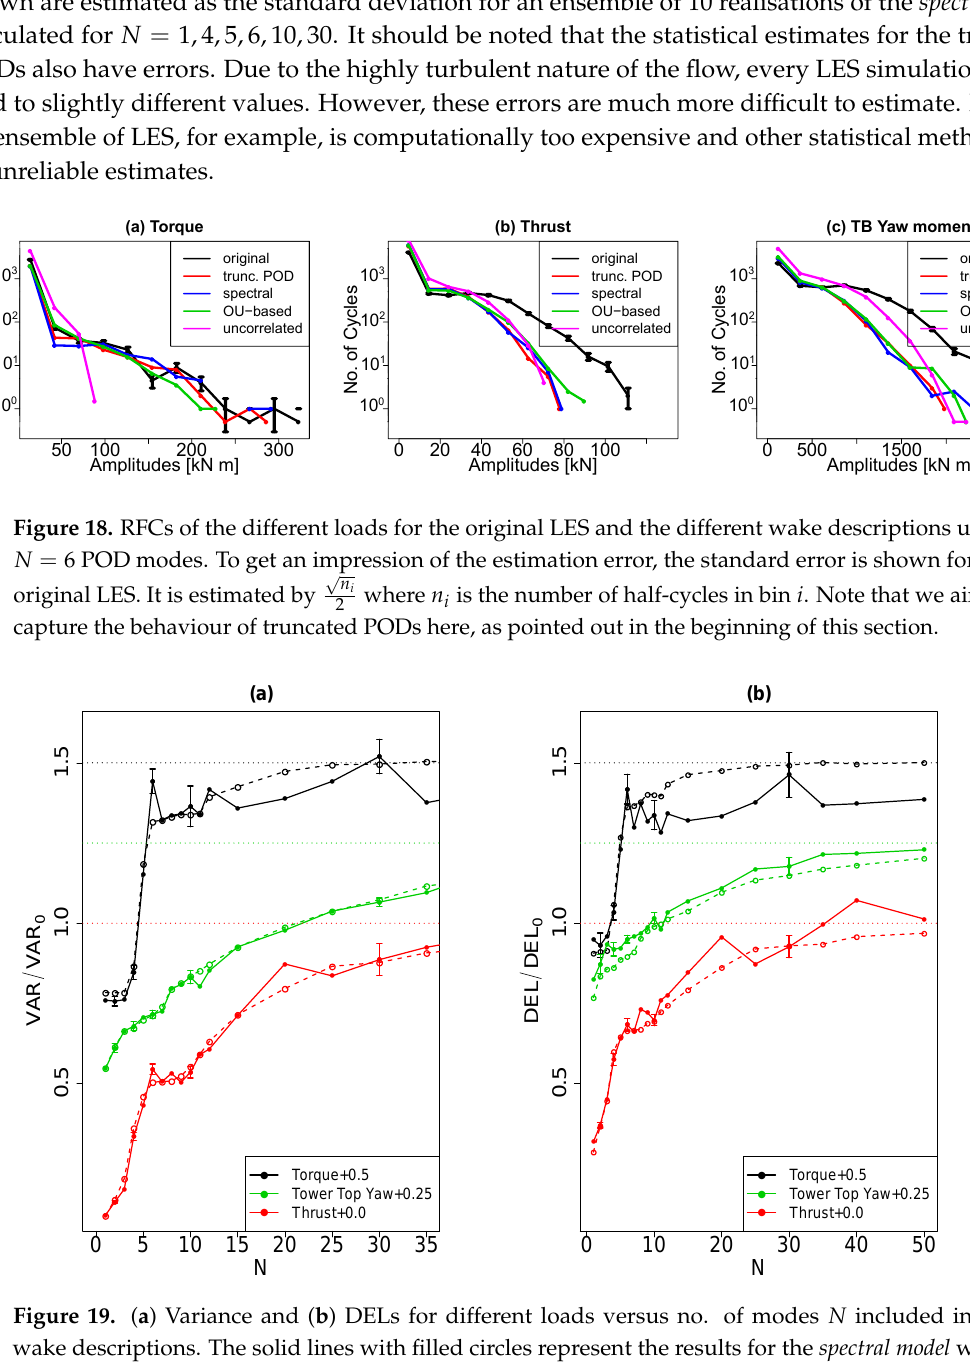
Figure 19. ( a ) Variance and ( b ) DELs for different loads versus no. of modes N included in the wake descriptions. The solid lines with filled circles represent the results for the spectral model while the dashed lines show the results for the truncated POD. The curves for the different loads are vertically shifted for a better visualisation, as described in the legend. The corresponding shifted values representing 1.0 are illustrated by the dotted lines. Standard errors are shown for the spectral model for N = 2,4,6,10,30. They are estimated through the standard deviation from an ensemble of 10